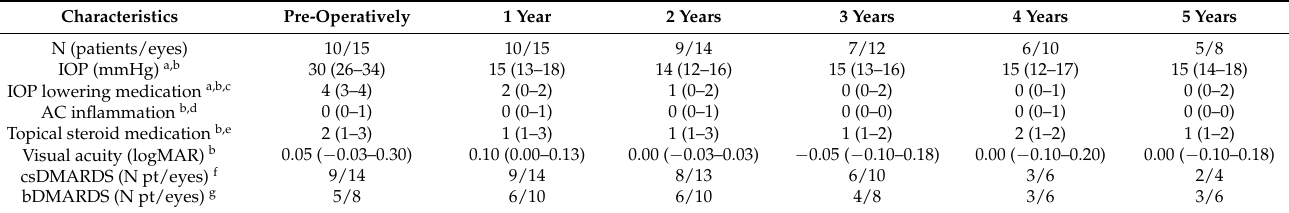
Figure 1. Median intraocular pressure (IOP; gray bars) and median number of IOP-lowering medications (line) after one goniotomy procedure based on 15 eyes in 10 patients. Error bars depict interquartile range of the IOP. Table 2. Primary and secondary outcomes during the